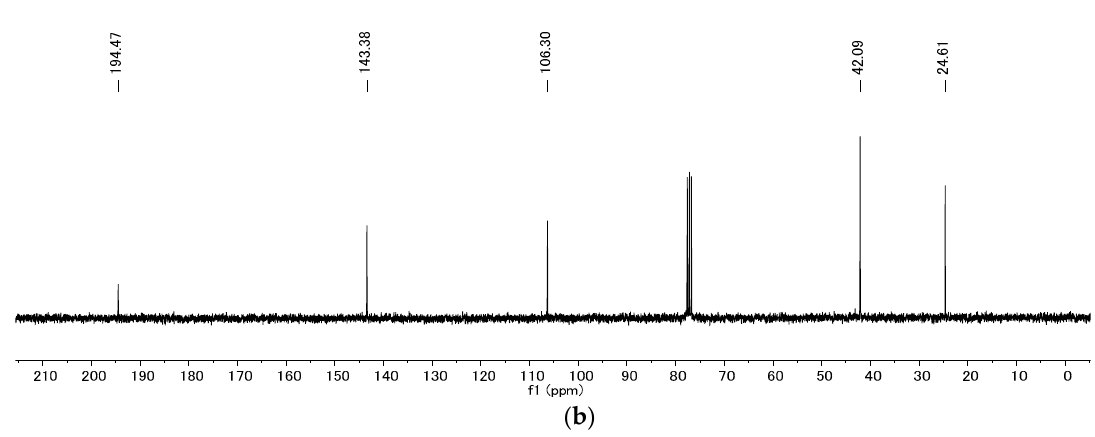
Figure 2. ( a ) 1 H NMR and ( b ) 13 C NMR spectra of 2,5-bis((dimethylamino)methylene)cyclopentanone ( 4 ).